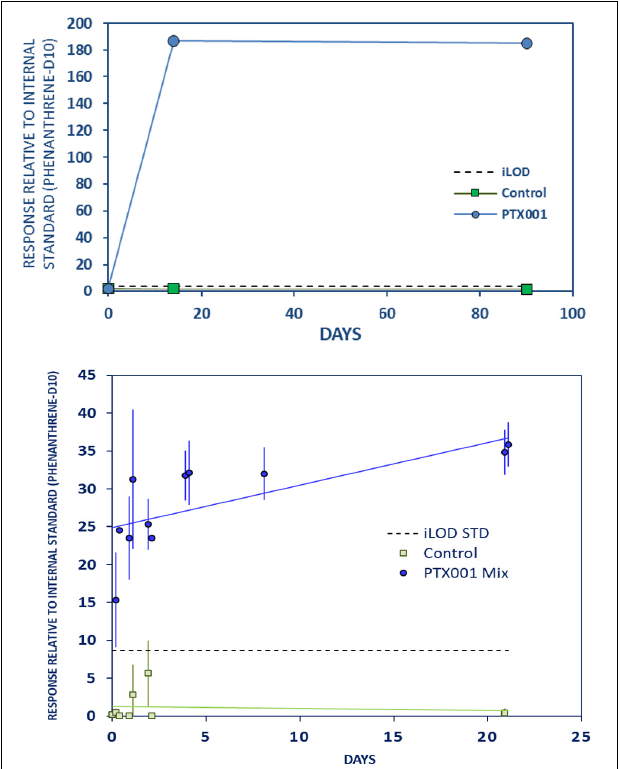
FIGURE 7 | Strong initial leaching of bumetrizole from PTX001 to stomach oil. Further caption details as in Figure 2